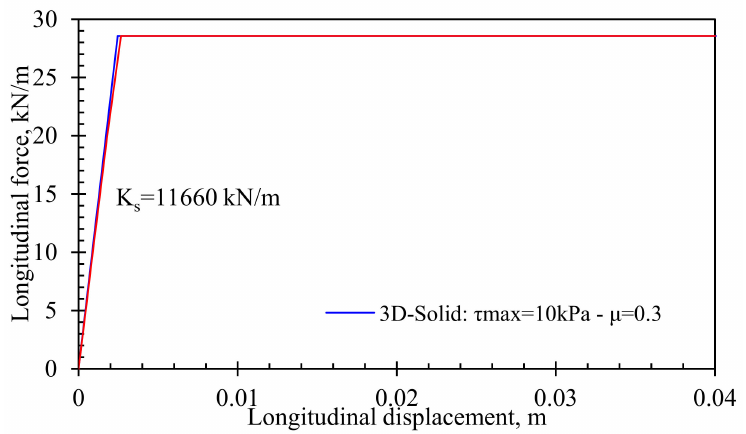
Figure 6. Longitudinal soil–pipe force–displacement curve of the beam–spring model versus the 3D solid model in the pull-out test with a contact friction coefficient 0.3.